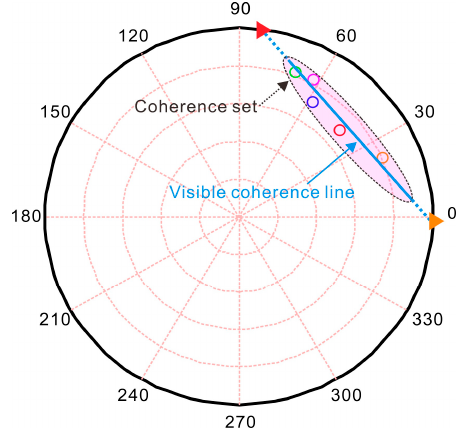
Figure 1. Geometrical interpretation of polarization coherence locus for Gaussian vertical backscatter (GVB).